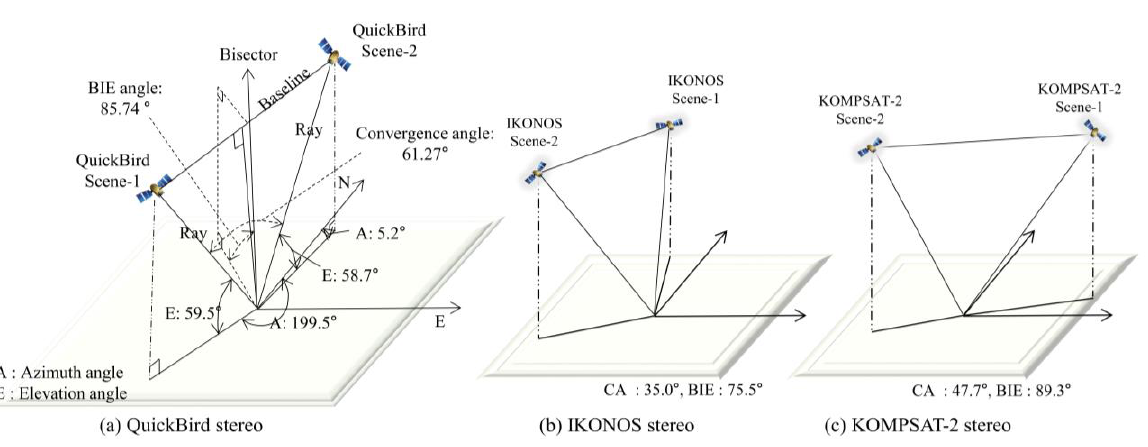
Figure 3. Stereo geometry of single-satellite stereo images.